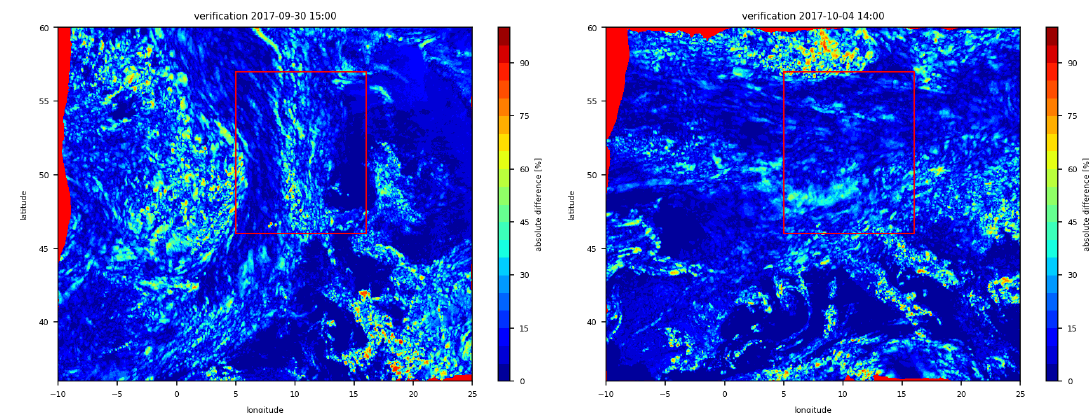
Figure 7. Verification plots of the optical flow method for the cases of 30 September 2017 at 15:00 UTC and 4 October 2017 at 14:00 UTC. The absolute difference between the effective cloud albedo from satellite imagery and the effective cloud albedo from the short-term forecast for 120 min in % is